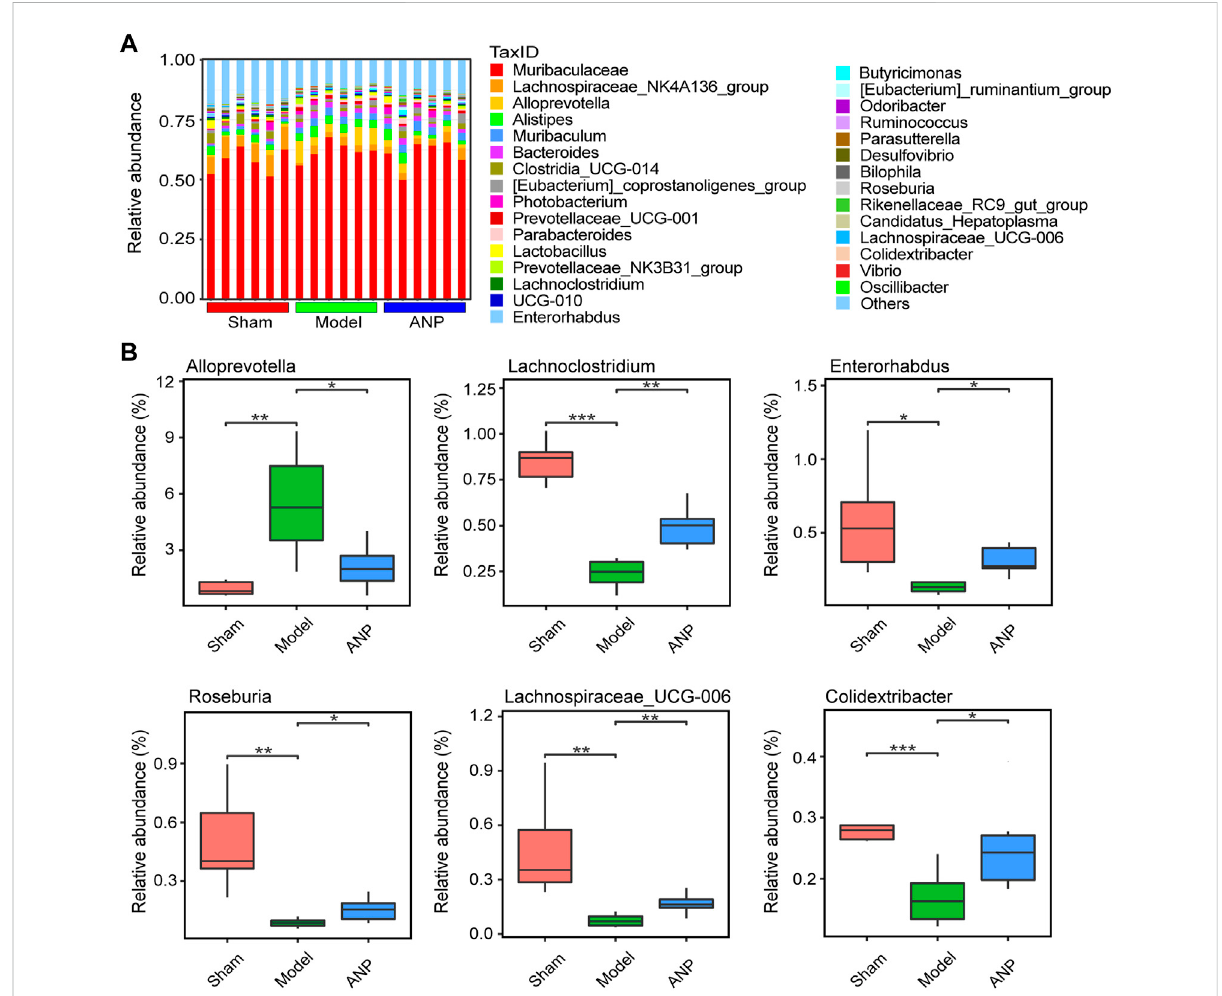
FIGURE 4 ANP regulated the gut microbiota at the genus level. (A) The gut microbiota composition at the genus level. (B) The statistical analysis at the genus level. Statistical differences were examined by t -test. * p < 0.05, ** p < 0.01, *** p <